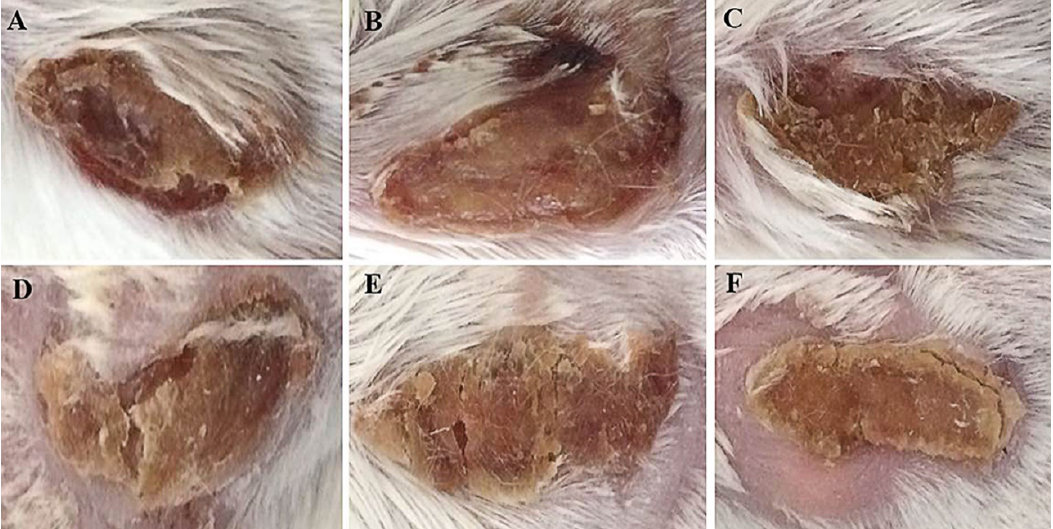
Figure 3. Macroscopic evaluation of wound at the 6th day in the infection model. Mice (n = 10 per group) were infected in the excision wound with MRSA ATCC43300 strain. ( A ) uninfected group, ( B ) control group, ( C ) 1% DPTM ointment treatment group, ( D ) 2% DPTM ointment treatment group, ( E ) 2% Retapamulin ointment treatment group, and ( F ) 3% DPTM ointment treatment group.